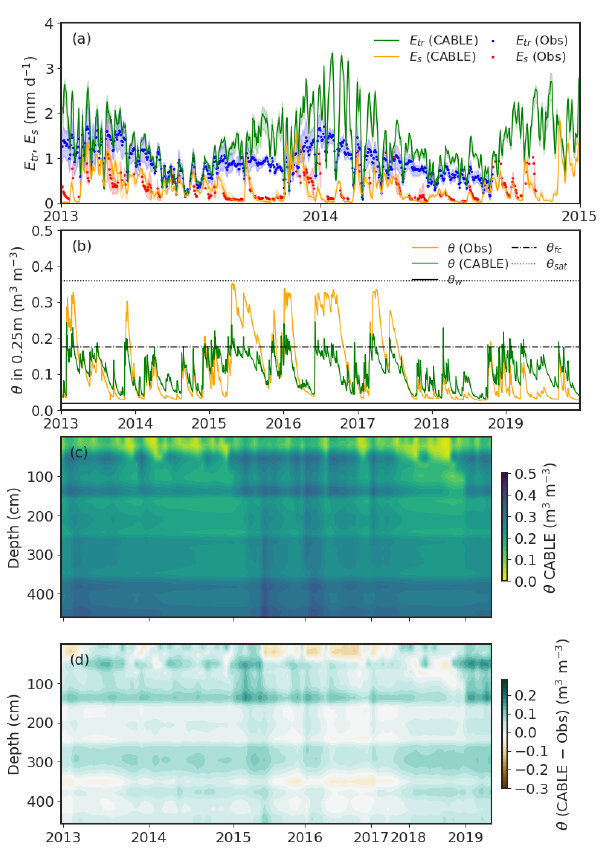
Figure 7. Site-based water stress function experiment ( β -exp). (a) E tr and E s between 2013 and 2015. The shaded areas repre- sent uncertainty between three ambient rings. Both simulations and observations are smoothed with a 3d window to aid visualisation. (b) θ in the top 0.25m from 2013 to 2019. (c) The vertical dis- tribution of θ in β -exp at observed dates from 2013 to 2019. (d) θ difference between CABLE and observations. Note the different time axis for panels (c, d) relative to panels (a, b) due to different sampling intervals for soil moisture and